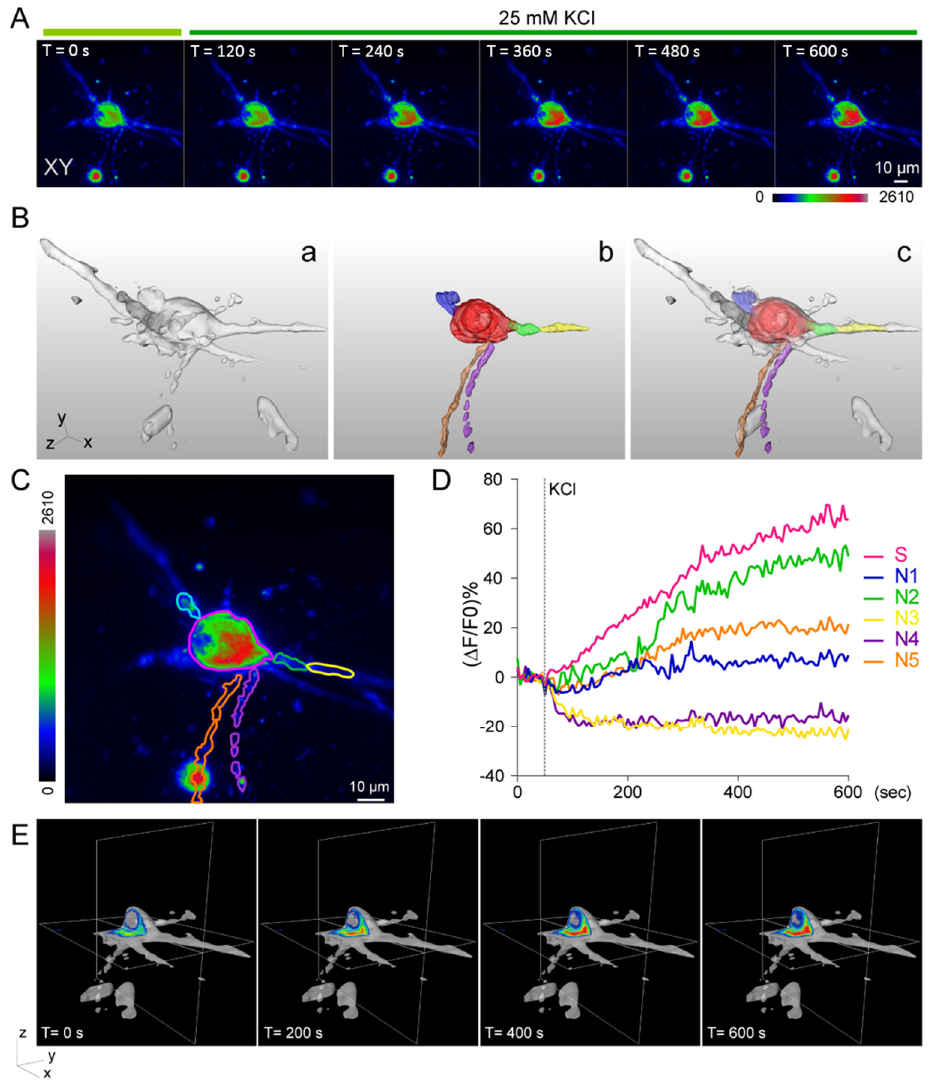
Figure 3. Voltage response of neuron to chemical stimulation (KCl). ( A ) Images of voltage dye-labeled neuron before and after 25 mM KCl treatment at different time points. Scale bar: 10 μ m. ( B ) The 3D segmentation and ROI images of voltage dye labeling neurons. The T0 image of (A) was used for 3D reconstruction and segmentation. Selected 3D ROIs are shown in different colors. The relative positions between ROIs (a) and (b) are overlaid, as shown in (c). ( C ) The maximum intensity projection of the T0 image and the outlines of ROIs. ( D ) The changes in the integrated intensity in different ROIs at different times before and after 25 mM KCl stimulation. The dashed line indicates the time point of stimulation. The intensity is normalized with ROI volume. ( E ) Cross-sectional view of voltage dye at different time points.